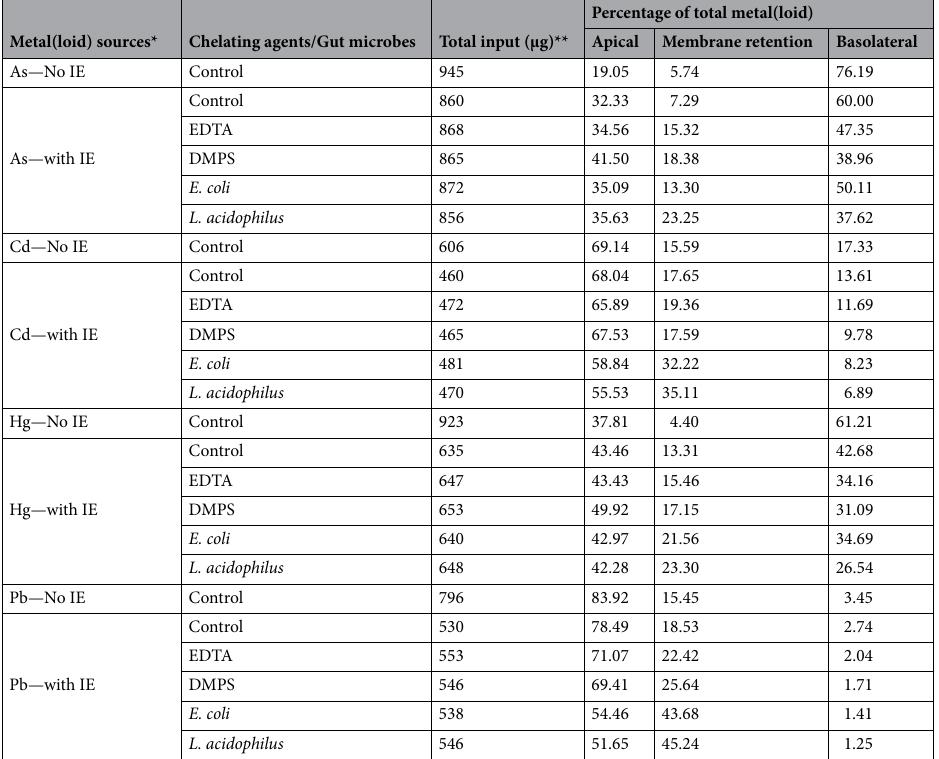
Table 2. Percentage distribution of metal(loid)s during permeability test using Caco-2 cell technique. *No IE, No Intestinal Extract; with IE, with Intestinal Extract. ** Based on the measured concentrations in the test metal(loid) samples in the presence and absence of intestinal extract. Ethylene diamine tetraacetic acid (EDTA) and 2,3-dimercapto-1-propanesulfonic acid (DMPS); Escherichia coli and Lactobacillus acidophilus.